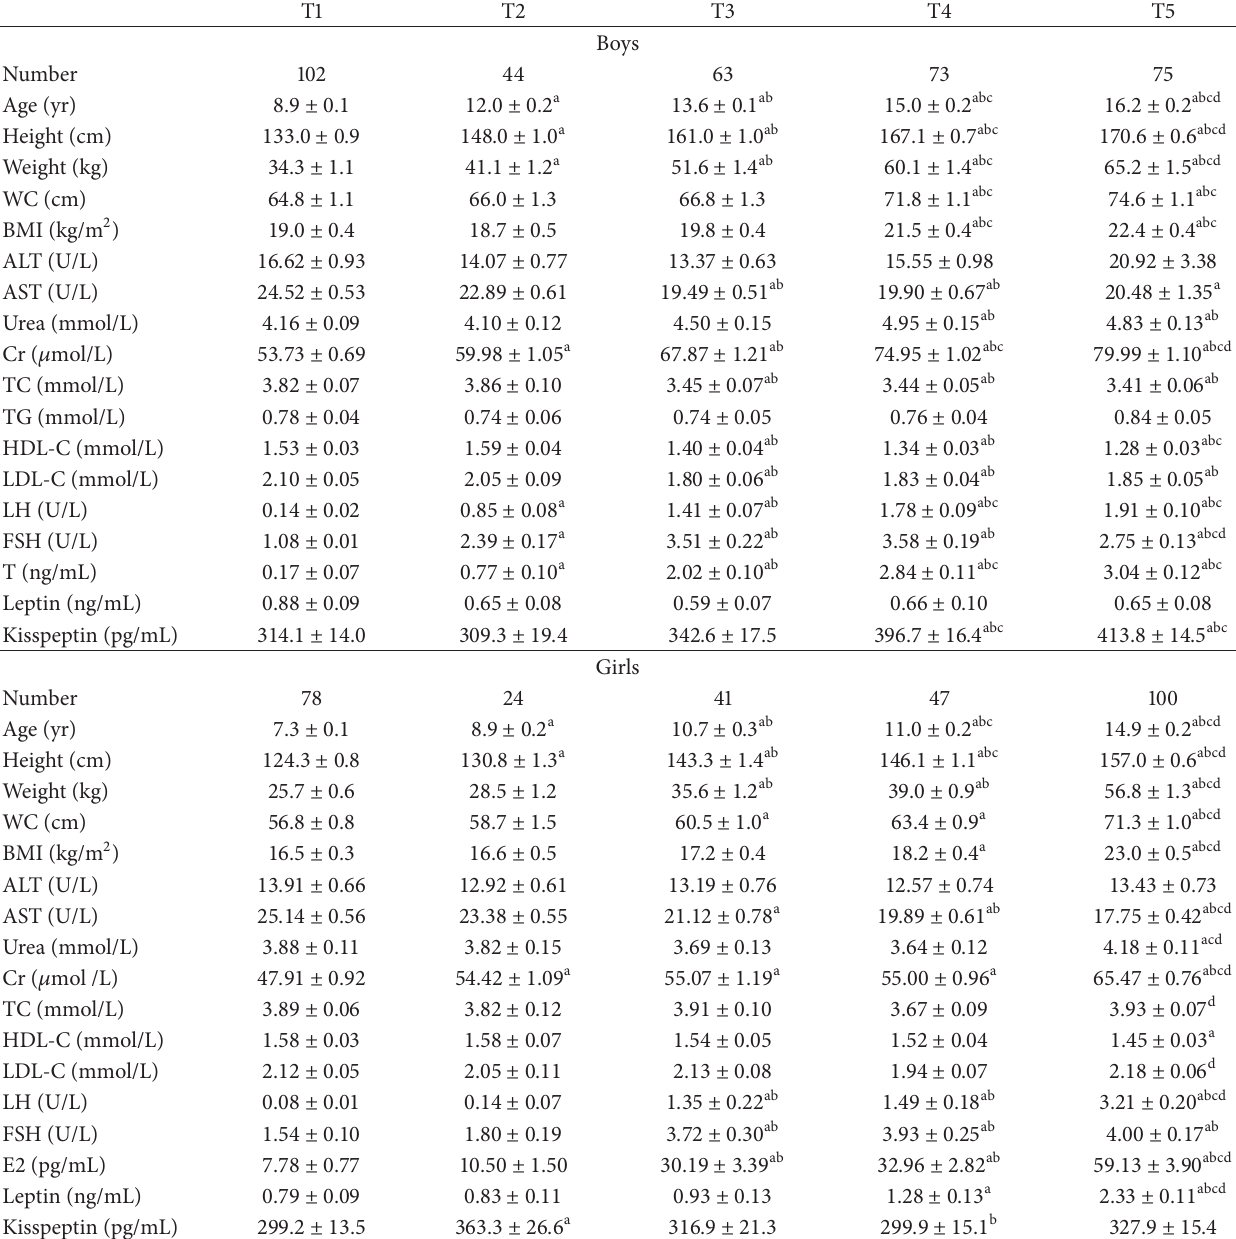
Table 1: The general characteristics of overall boys and girls in different pubertal stages (mean ±